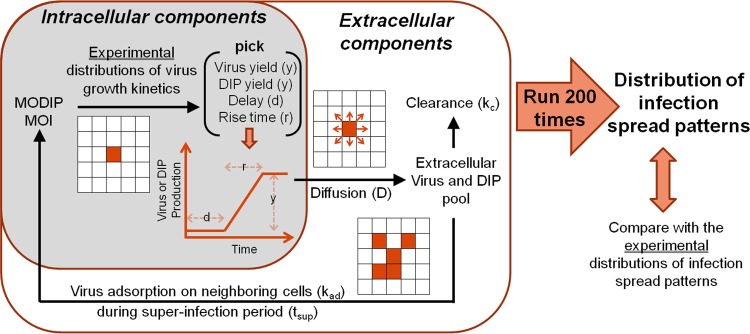
Data-driven cellular automaton model of virus-DIP interactions during infection spread. Infection starts at the center of a square grid at a given initial MODIP and MOI. As described in the shaded box, the experimentally determined mathematical relationships linking the MODIP to distributions of virus growth kinetics (virus yield, delay, and rise time) (47) are used to generate virus growth profiles. DIP yields from single cells are calculated as the difference between the infectious virus yield and maximum virus production from a cell. Virus growth is assumed to be linear and continuous. Once the virus and DIPs are released to the extracellular pool at a specific cell location, they can diffuse to neighboring cells at a particular diffusion constant (D), adsorb onto uninfected cells at a certain adsorption efficiency (kad) during the superinfection period (tsup) of cells, or clear at a particular clearance rate (kc). The model runs for the desired period (e.g., 30 hpi) with time steps of 6 min, satisfying forward Euler stability criteria. By 200 iterations of the model, a distribution of infection spread patterns at a given set of model parameters and a given initial MODIP can be obtained and compared with experimental results.